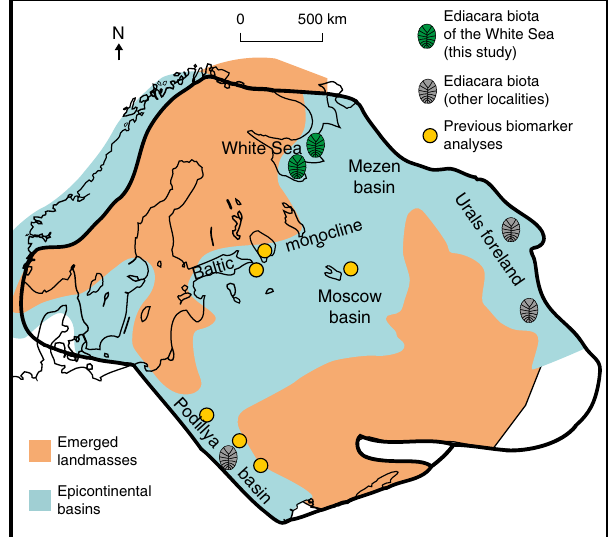
Fig. 1 Map contrasting the fossil and biomarker localities of this (green) and previous (orange) biomarker studies at the East European Platform. The grey symbols indicate known localities of the Ediacara biota where sediments are too thermally mature to preserve biomarkers. Modi fi ed after Pehr et al. 17 and Sliaupa et al. 50